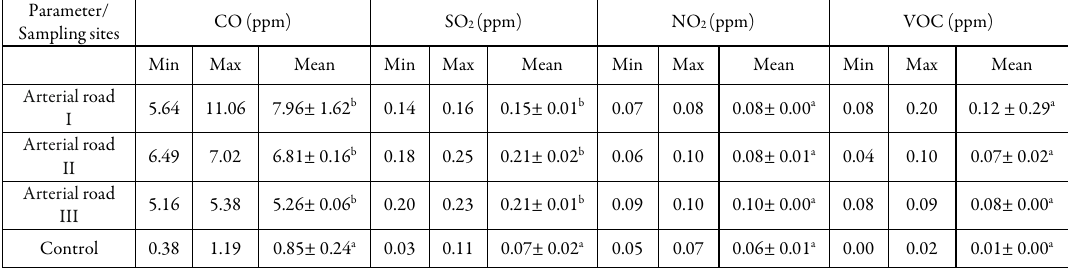
Table 2. Ambient air quality of Kumasi Metropolis during the study period Parameter/ Sampling sites